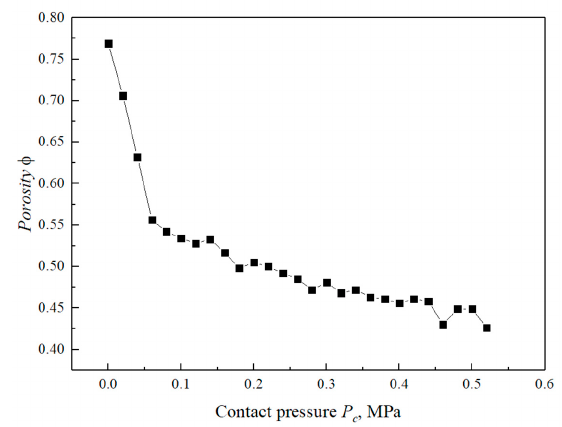
Figure 9. The influence of the contact pressure on the porosity.